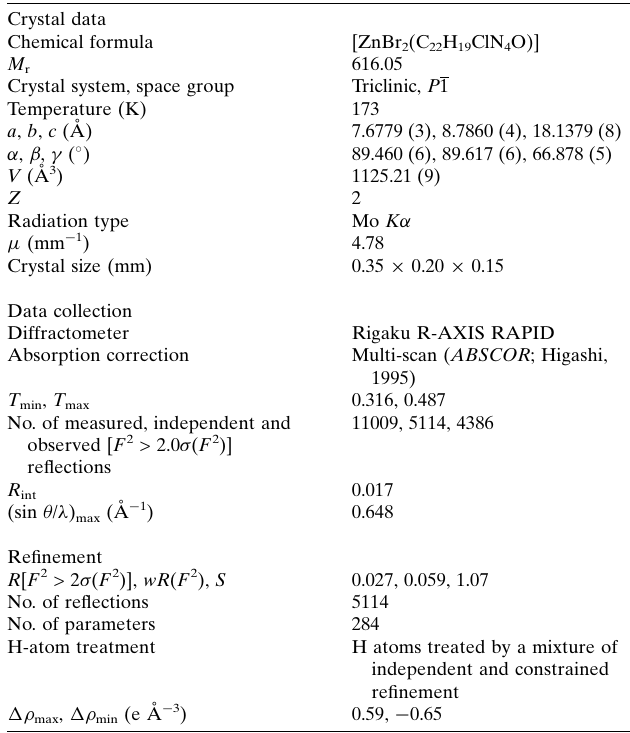
Table 2 Experimental details.